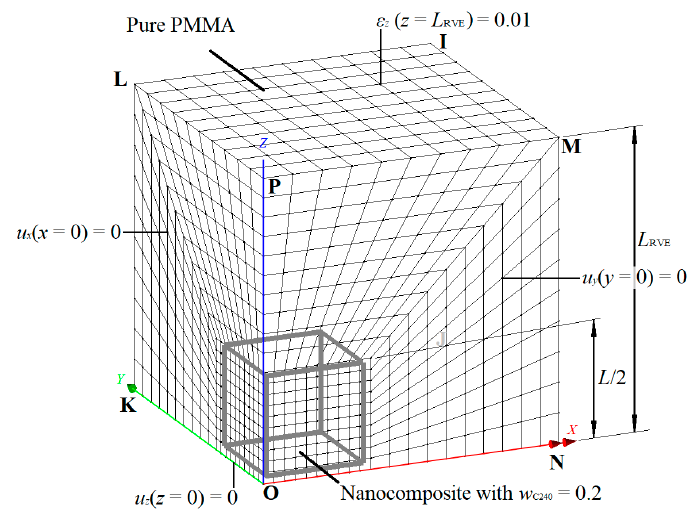
Figure 4. Geometry, boundary conditions, and finite element discretization of the nanocomposite RVE with a mass fraction of w C240 = 0.05 (1/8 of the periodic volume of the whole system domain). The edge length of the nanocomposite subdomain with w C240 = 0.2 is taken equal to L /2, where L is the corresponding unit cell length computed via the MD-only simulation at the first scale analysis.